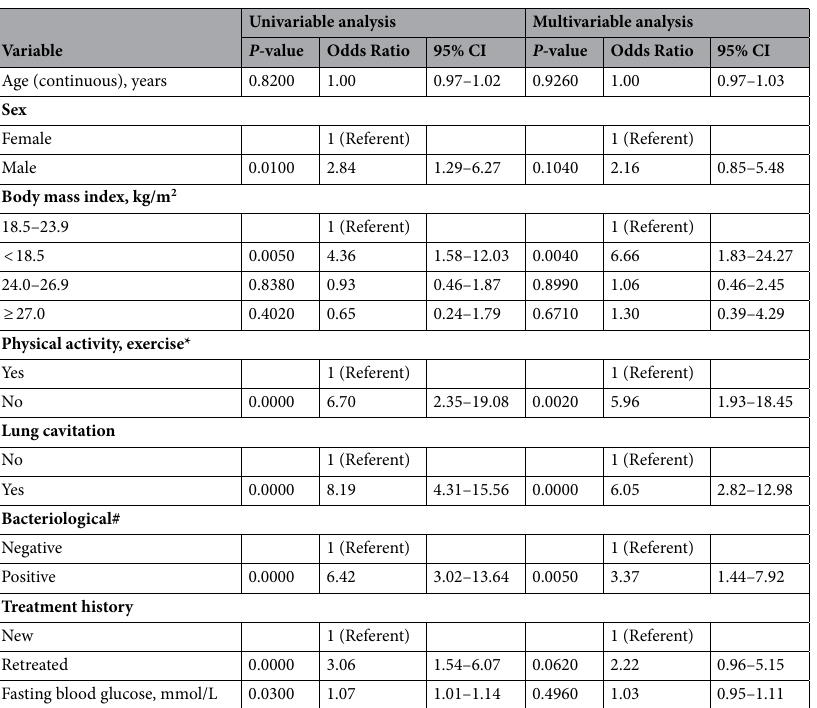
Table 2. Risk factors for poor treatment outcomes in persons living with diabetes and tuberculosis in eastern China. *BMI, Body mass index, taking into account factors such as differences in the diet and physique of Chinese and foreigners, BMI of this study is classified by Chinese standards, including < 18.5 was thin, 18.5– 23.9 was normal level, 24.0–26.9 was overweight and ≥ 27.0 was obesity. Physical Activity, Exercise, including walking, running or other forms of exercise. Bacteriological#, including the result of sputum culture or smear examination.